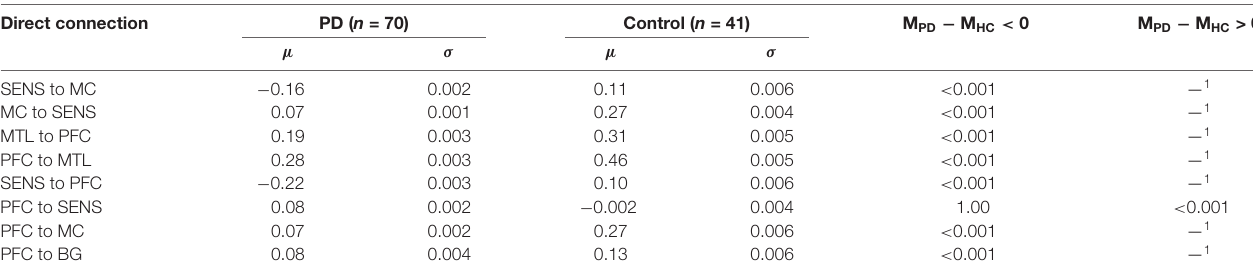
TABLE 2 | Group comparison of direct connectivity between PD and Control